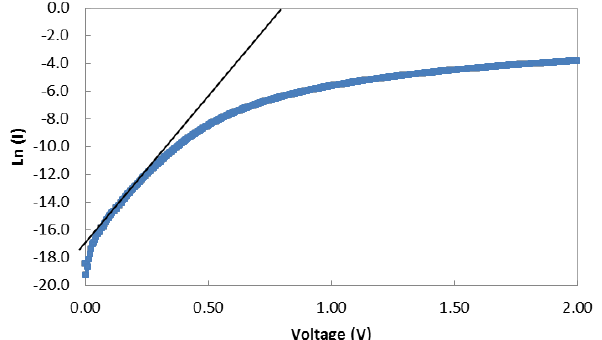
Figure 6. ln ( I ) vs V plot using method 1.